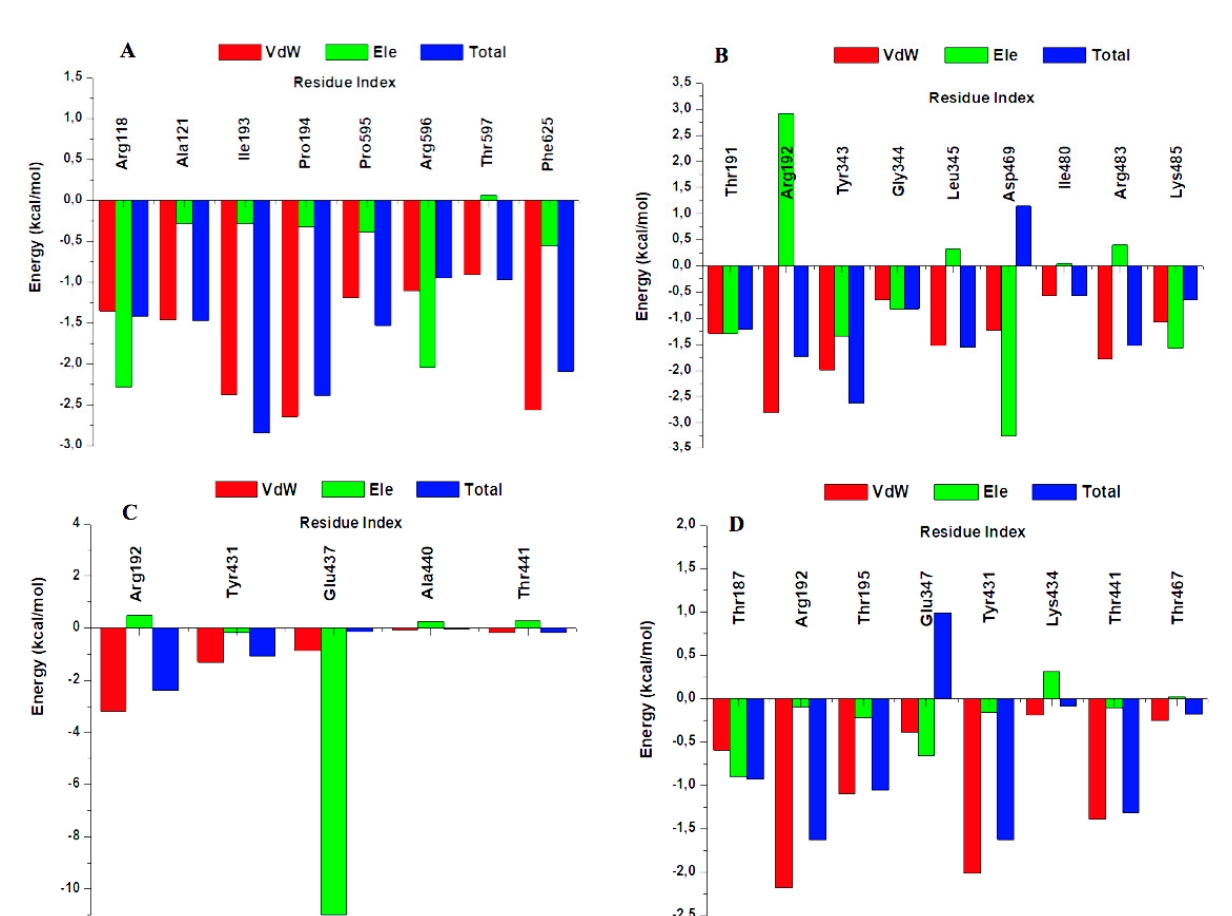
Figure 4. Per-residue decomposition analysis of FadD32-Accolate ( A ), FadD32-Sorafenib ( B ), FadD32-Mefloquine, ( C ) and FadD32-Loperamide ( D ).